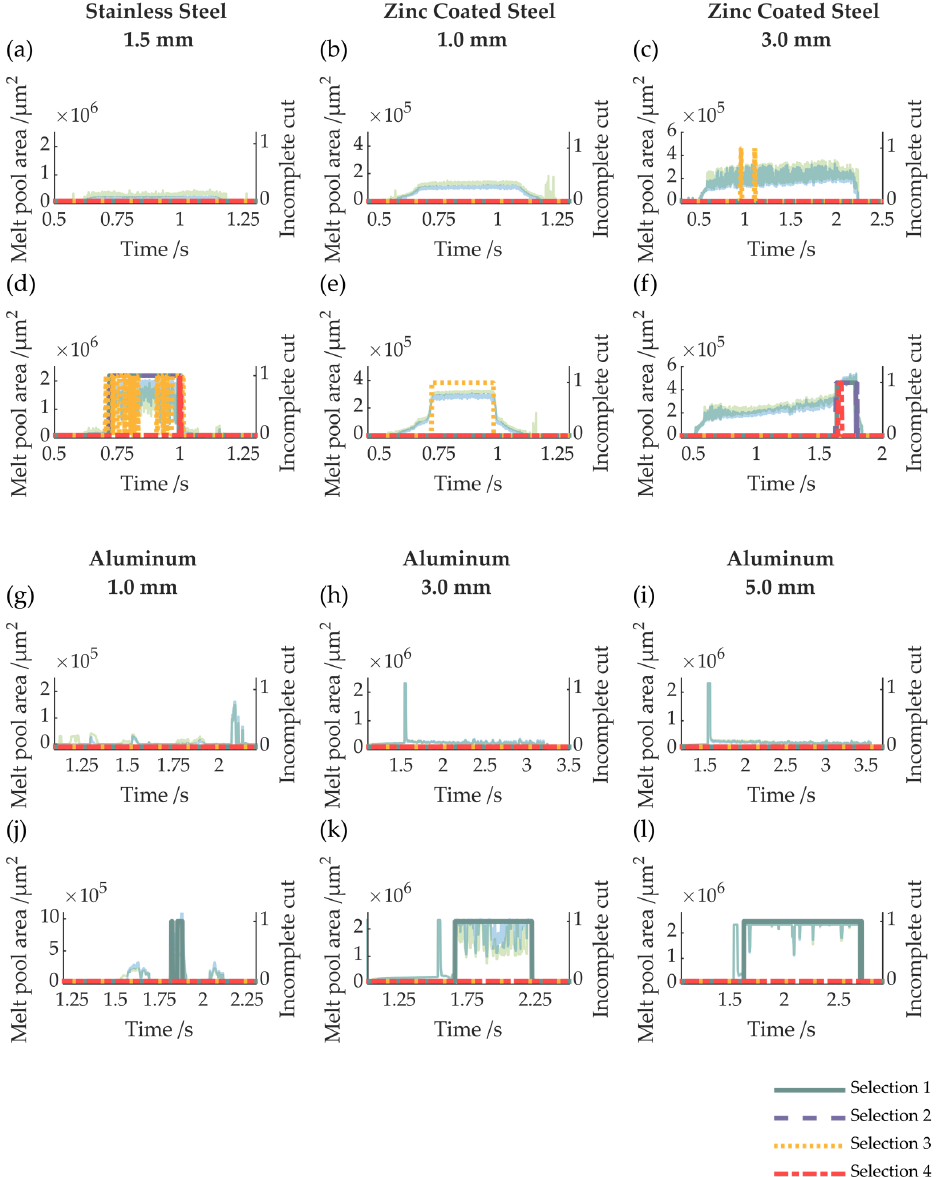
Figure 12. Signals for the green and blue channels and the signals of the interruption detection of complete cuts ( a – c ) and incomplete cuts ( d – f ) for stainless steel with a sheet thickness of 1.5 mm and zinc-coated steel with a sheet thick-ness of 1.0 and 3.0 mm and of complete cuts ( g – i ) and incomplete cuts ( j – l ) for aluminum for sheet thicknesses of 1.0, 3.0, and 5.0 mm.